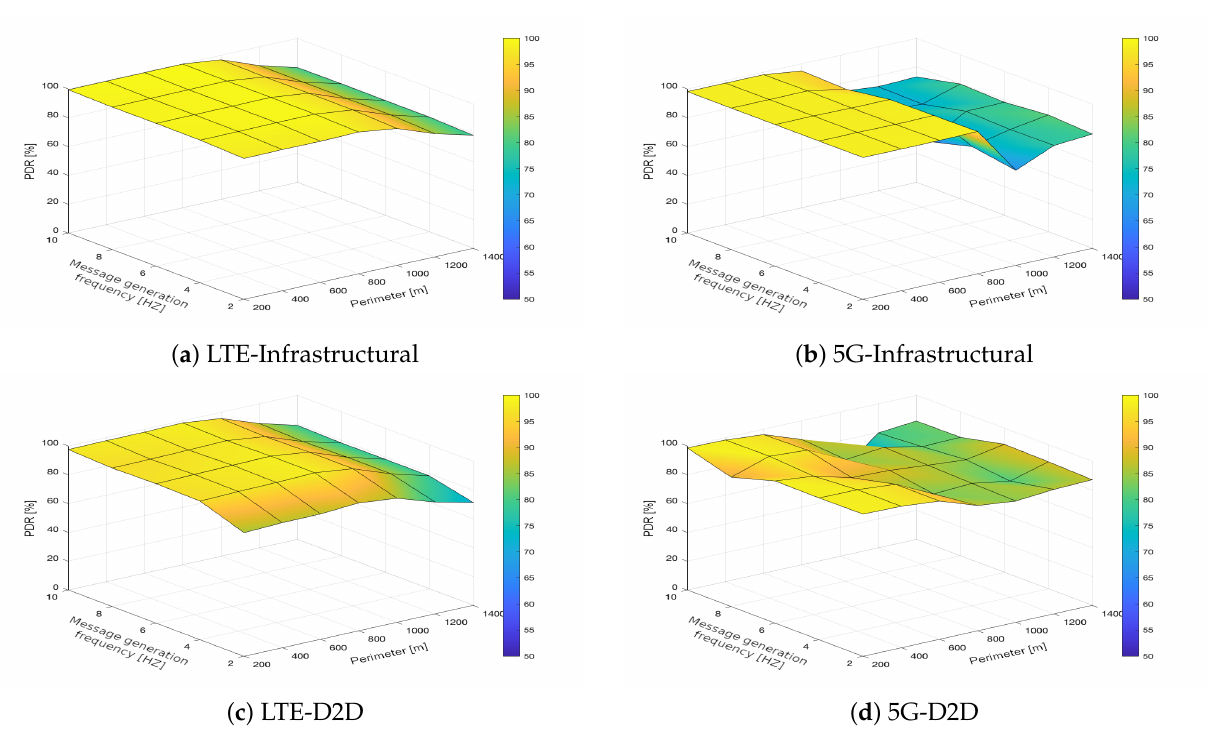
Figure 3. PDR simulated for all the investigated modes of the 4G-based and 5G-based C-V2X technologies and traffic intensity of 5O0 vehicles per